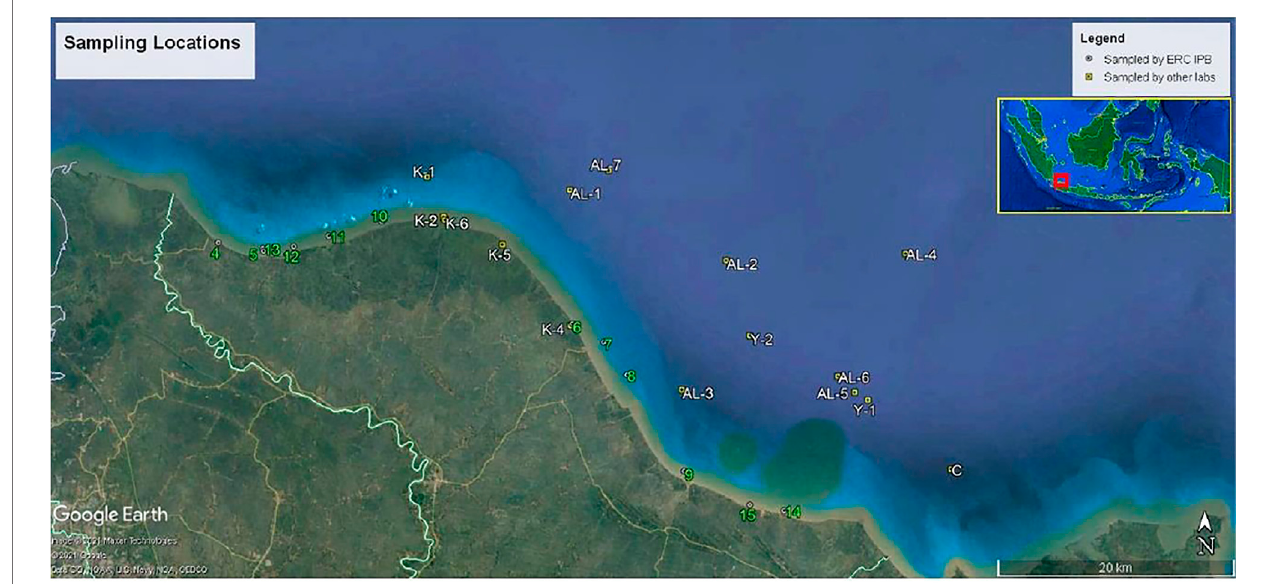
FIGURE 1 | Sketch of seawater quality sampling locations in Karawang Regency.